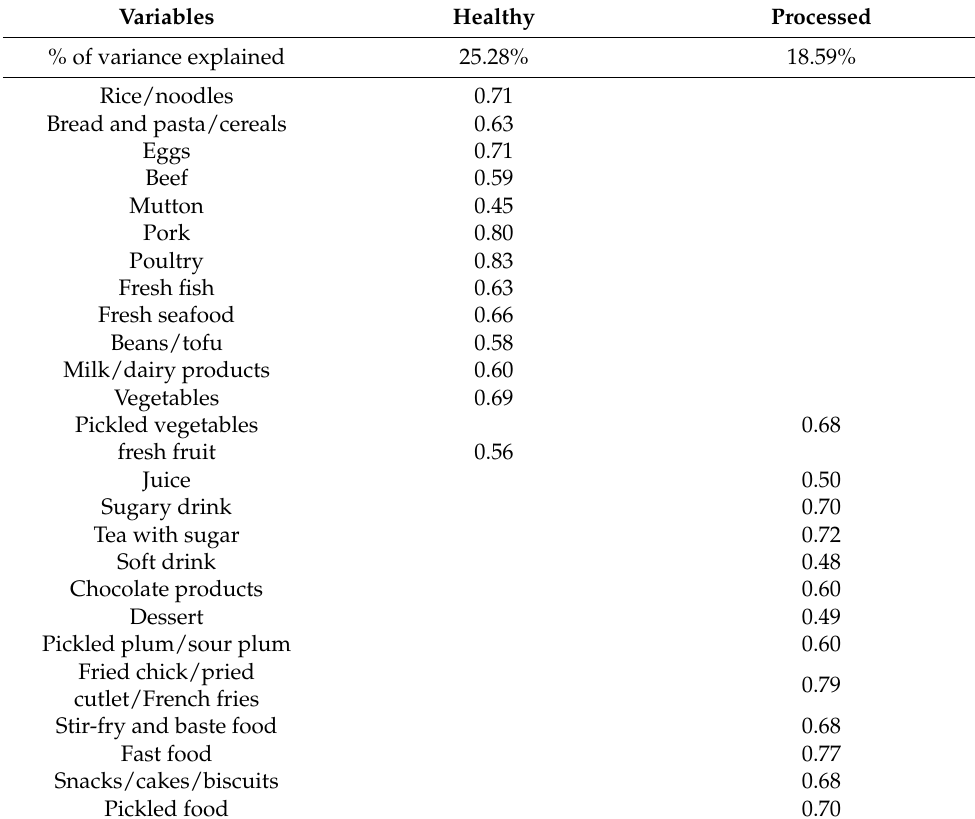
Table 1. Dietary pattern loading factors from factor analysis using varimax